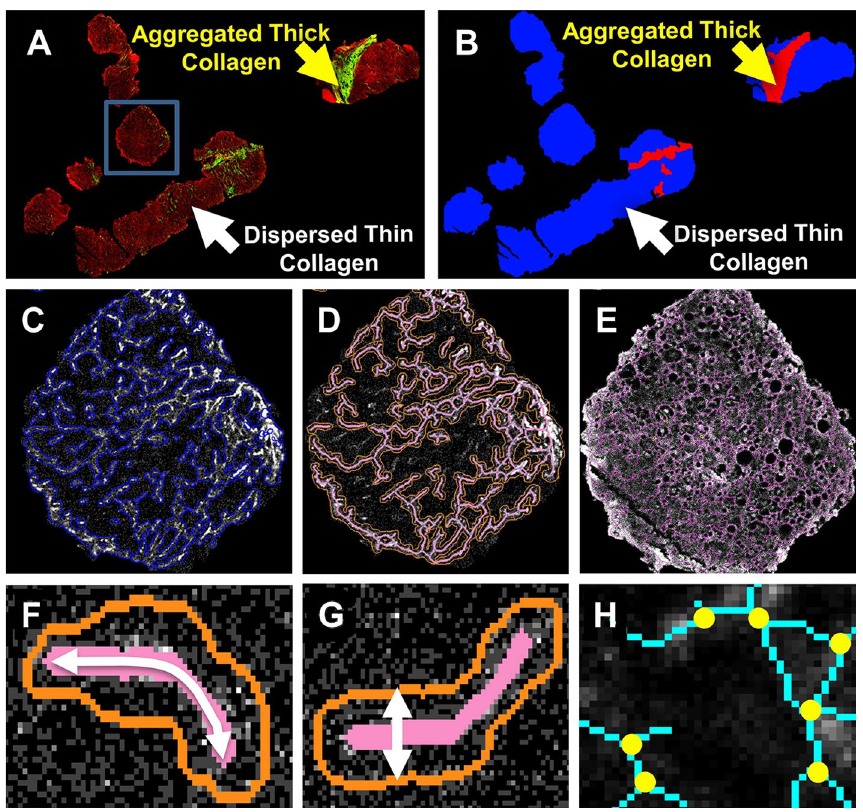
Figure 2. Quantitative collagen structural features extracted from automatic image analysis. ( A ) Representative TPE (red) and SHG (green) images, which specify the collagen structures. The collagen has two distinct models: aggregated thick collagen (ATC) and dispersed thin collagen (DTC). The ATC area contains highly concentrated and aggregated collagen fibers as indicated by the yellow arrow. The collagen in the DTC area is evenly and sparsely distributed as shown by the white arrow. The blue box indicates the area depicted in parts ( C – E ). ( B ) Our intensity-morphology based filter is able to differentiate these two types of regions successfully as shown by the yellow and white arrow. ( C ) The collagen signal is detected using a GMM model, and their connectivity is preserved for a better structural description. ( D ) Skeletonization was applied to the collagen binary image in order to identify the central line of the fiber network. ( E ) Similar solutions are applied to the TPE channel, and we extract the features from TPE accordingly. ( F ) Illustration of collagen fiber length (CFL). ( G ) Illustration of collagen fiber thickness (CFT). ( H ) Junction points detection (yellow dots) to measure the collagen network